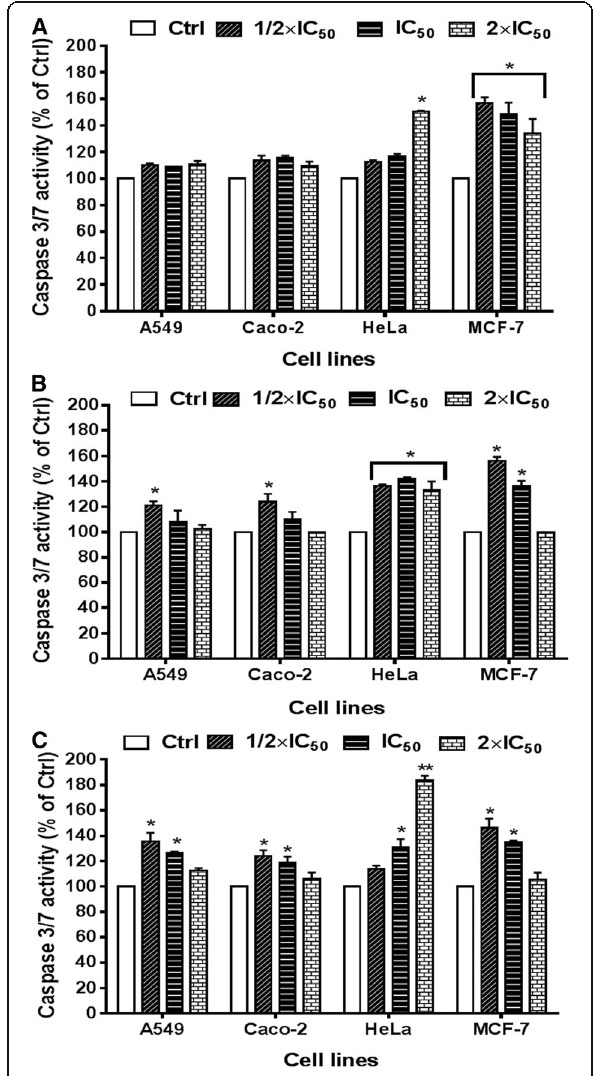
Fig. 2 Activation of caspase-3/ − 7 after 24 h of treatment with acetone leaf extracts of Croton sylvaticus ( a ), Croton pseudopulchellus ( b ) and Croton gratissimus ( c ) on cancerous A549, Caco-2, HeLa and MCF-7 cells. The caspase-3/ − 7 activity is expressed as percentage or fold change to the untreated cells (control). Data are presented as mean ± standard error of three independent experiments. * P < 0.05 and ** P < 0.01 indicate the significant difference compared to the control. CSA, CPA and CGA represent respectively acetone leaf extracts of Croton sylvaticus , Croton pseudopulchellus and Croton gratissimus. Ctrl: control group (0.5% DMSO)